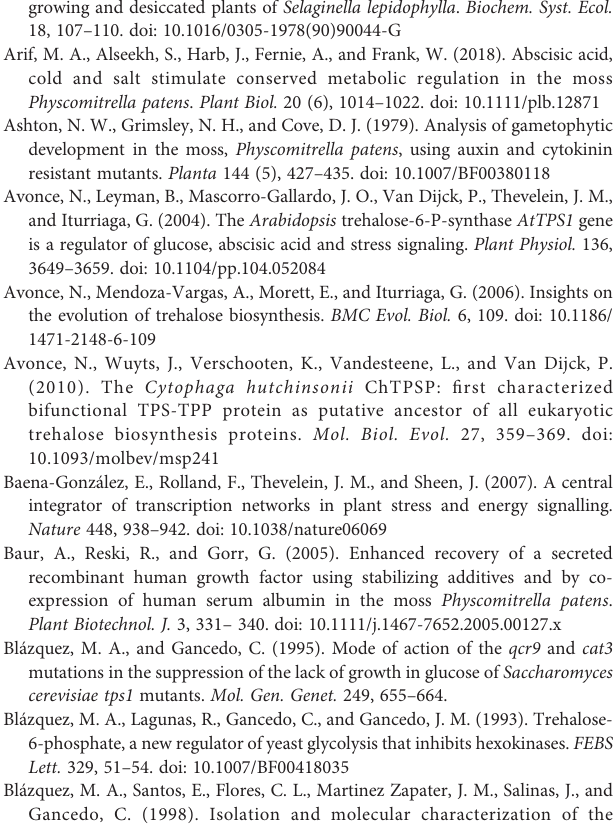
SUPPLEMENTARY FIGURE 3 | Effect of high light (50 µmol m-2s-1) in combination with sugar on growth of wild-type (WT) and the tps1 Δ tps2 Δ